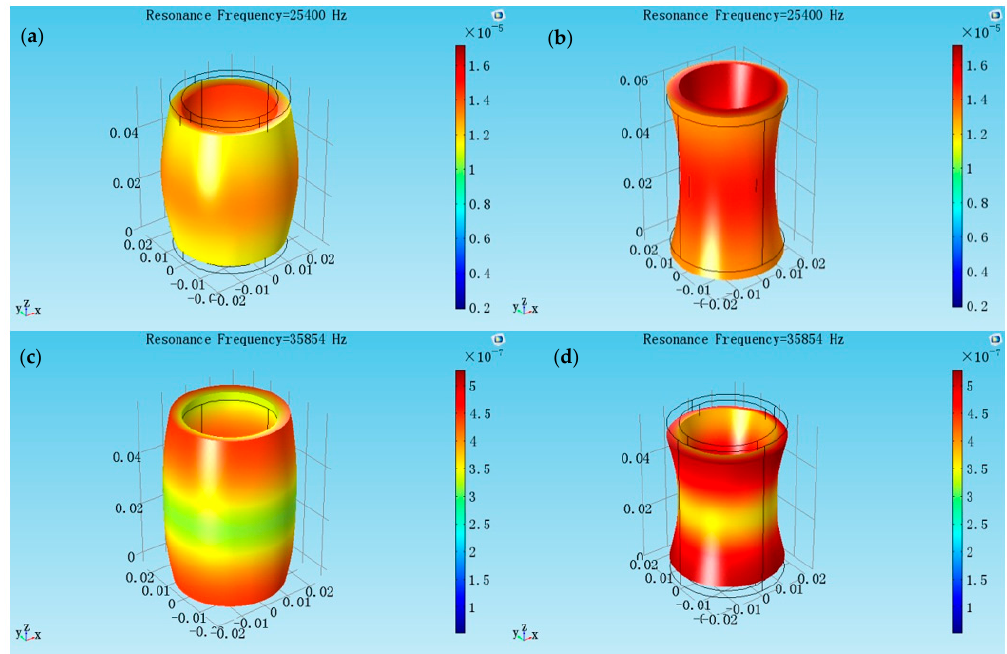
Figure 5. The coupled vibration modes of the cylindrical transducer at aspect ratio of l/2b = 1.4. ( a , b ) The radial extensional vibration mode of the coupled vibration; ( c , d ) The longitudinal extensional vibration mode of the coupled vibration.